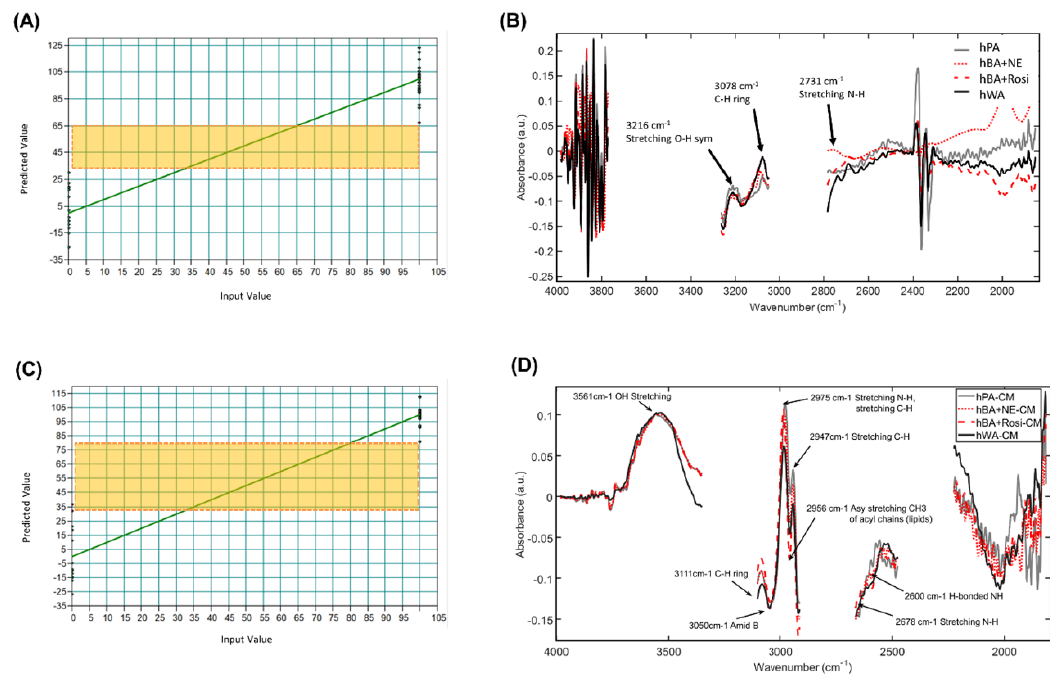
Figure 2. PLSR using FTIR spectra of human adipocytes on a gelatin-coated slide glass and human adipocyte-conditioned media on a slide glass. ( A ) PLSR for hBA on a gelatin-coated slide glass and transparent yellow box indicating non-overlapping area. ( B ) Pre-processed spectra used in PLSR for hBA on a gelatin-coated slide glass. ( C ) PLSR for hBA-CM on a slide glass and transparent yellow box indicating non-overlapping area. ( D ) Pre-processed spectra used in PLSR for hBA-CM on a slide glass.